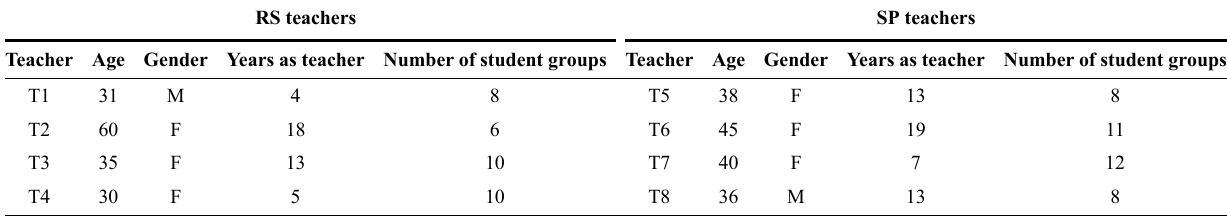
Table 1 - Characterization of